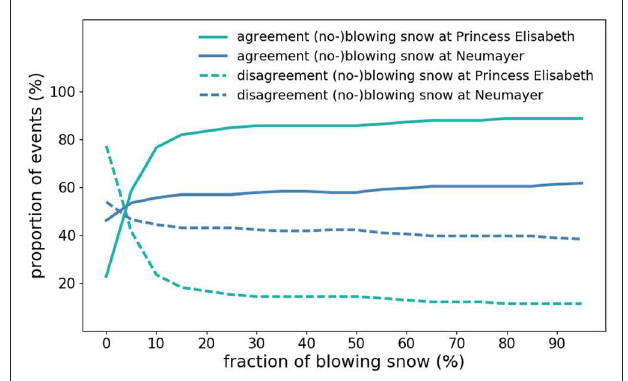
FIGURE 2 | Distribution on agreement on (no-) blowing snow (solid lines) and disagreement on (no-)blowing snow (dashed lines) at Princess Elisabeth station (green) and Neumayer station